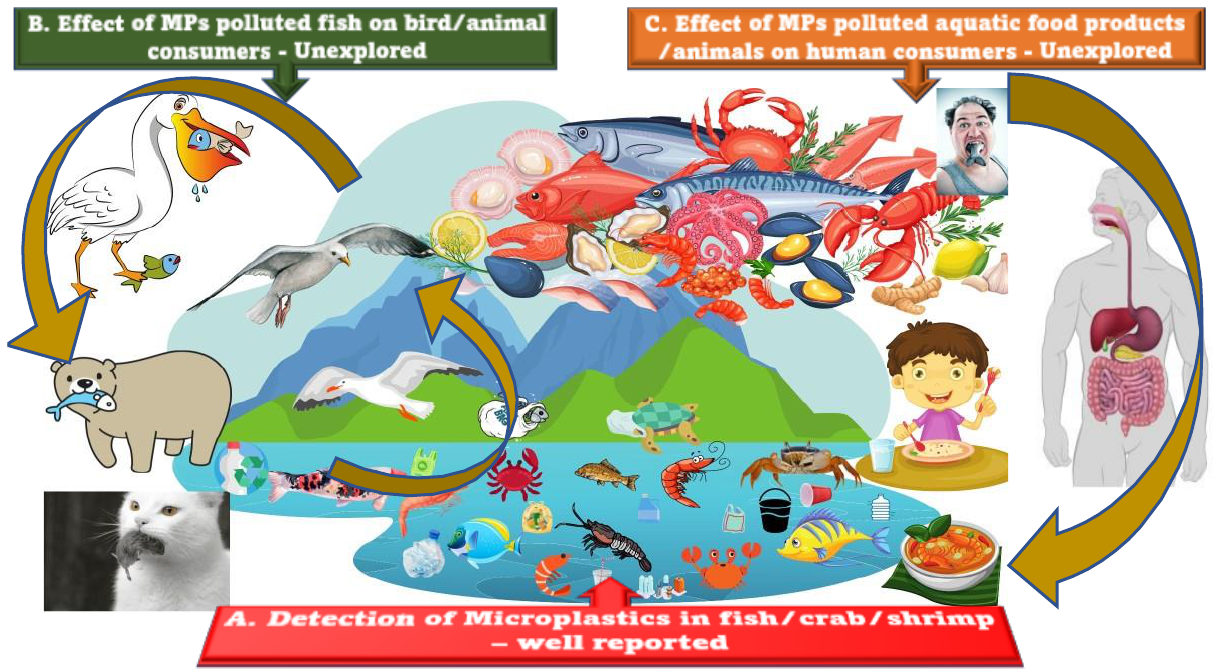
Figure 2. Schematic representation of the major discussion points of this review, which highlights the fact that (A) the detection of MPs in fish/crab/shrimps are supported by extensive reports, while the interlinked aspects of (B) effects of MPs-polluted fish on bird/animal consumers and (C) on hu- man consumers has meagre scientific evidence. consumers has meagre scientific